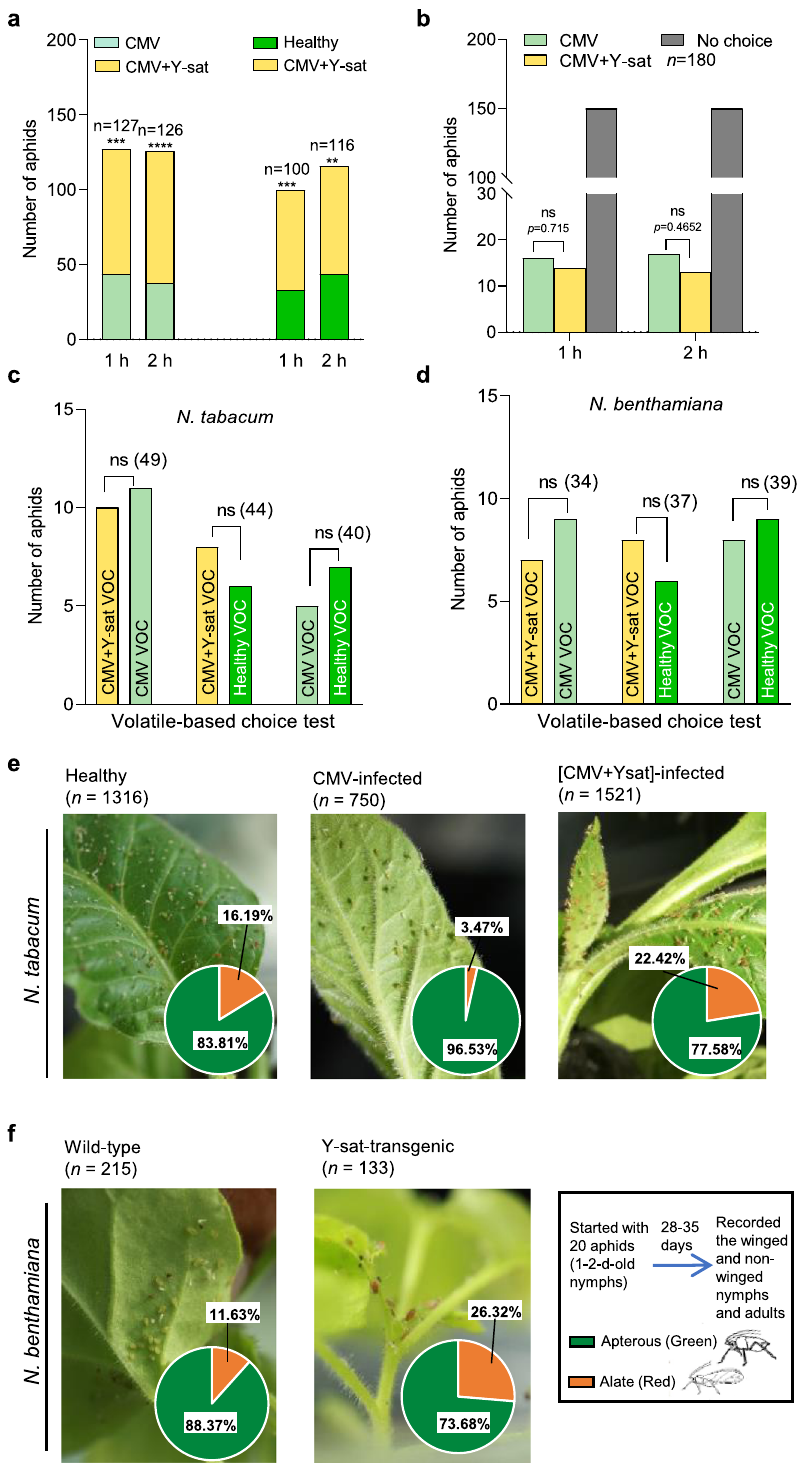
P = 0.0093) (Fig. 3a). To further con fi rm the yellow attraction of aphid, we performed an aphid attraction bioassay in the dark. As we expected, the majority (~83.3%) of aphid did not move to both CMV- and [CMV + Y-sat]-infected plants ( χ 2 = 80, d.f. = 1, P < 0.0001). As a result, there was no signi fi cant difference between the two plants (1 h, χ 2 = 0.1333, d.f. = 1, P = 0.715; 2 h, χ 2 = 0.5333, d.f. = 1, P = 0.4652) (Fig. 3b), suggesting that aphids rely on their eyesight for probing plants. In a given